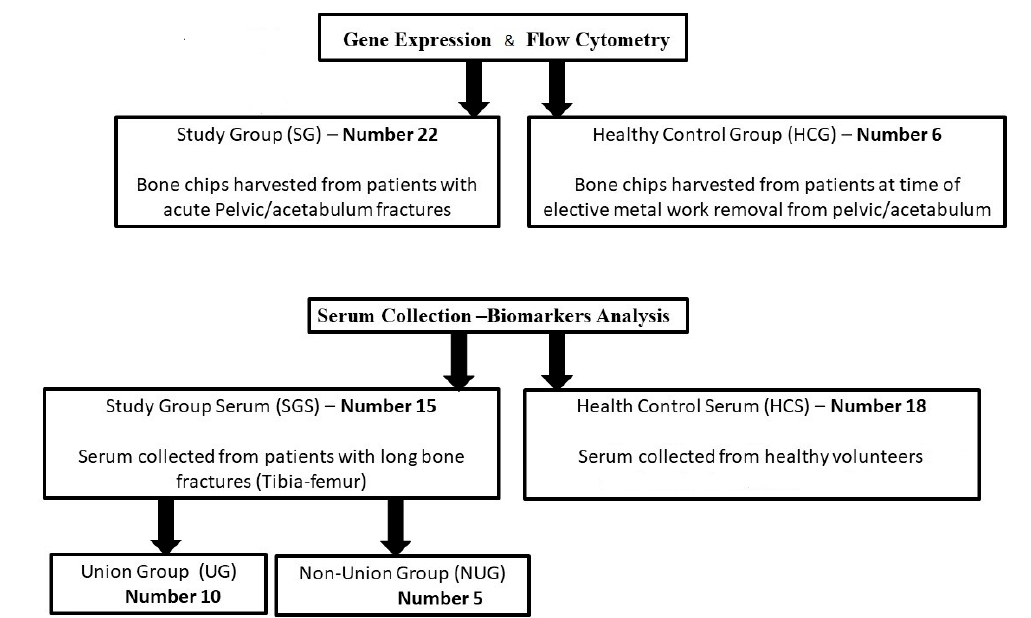
Figure 1. Schematics of the study groups used in this work. Of note, 4 samples from the SG group did not yield sufficient/good-quality RNA to be included in the gene expression study. Similarly, the number of cells recovered after collagenase digest was not sufficient to perform the flow cytometry analysis on all samples, leaving 4 HCs and 15 fractures.